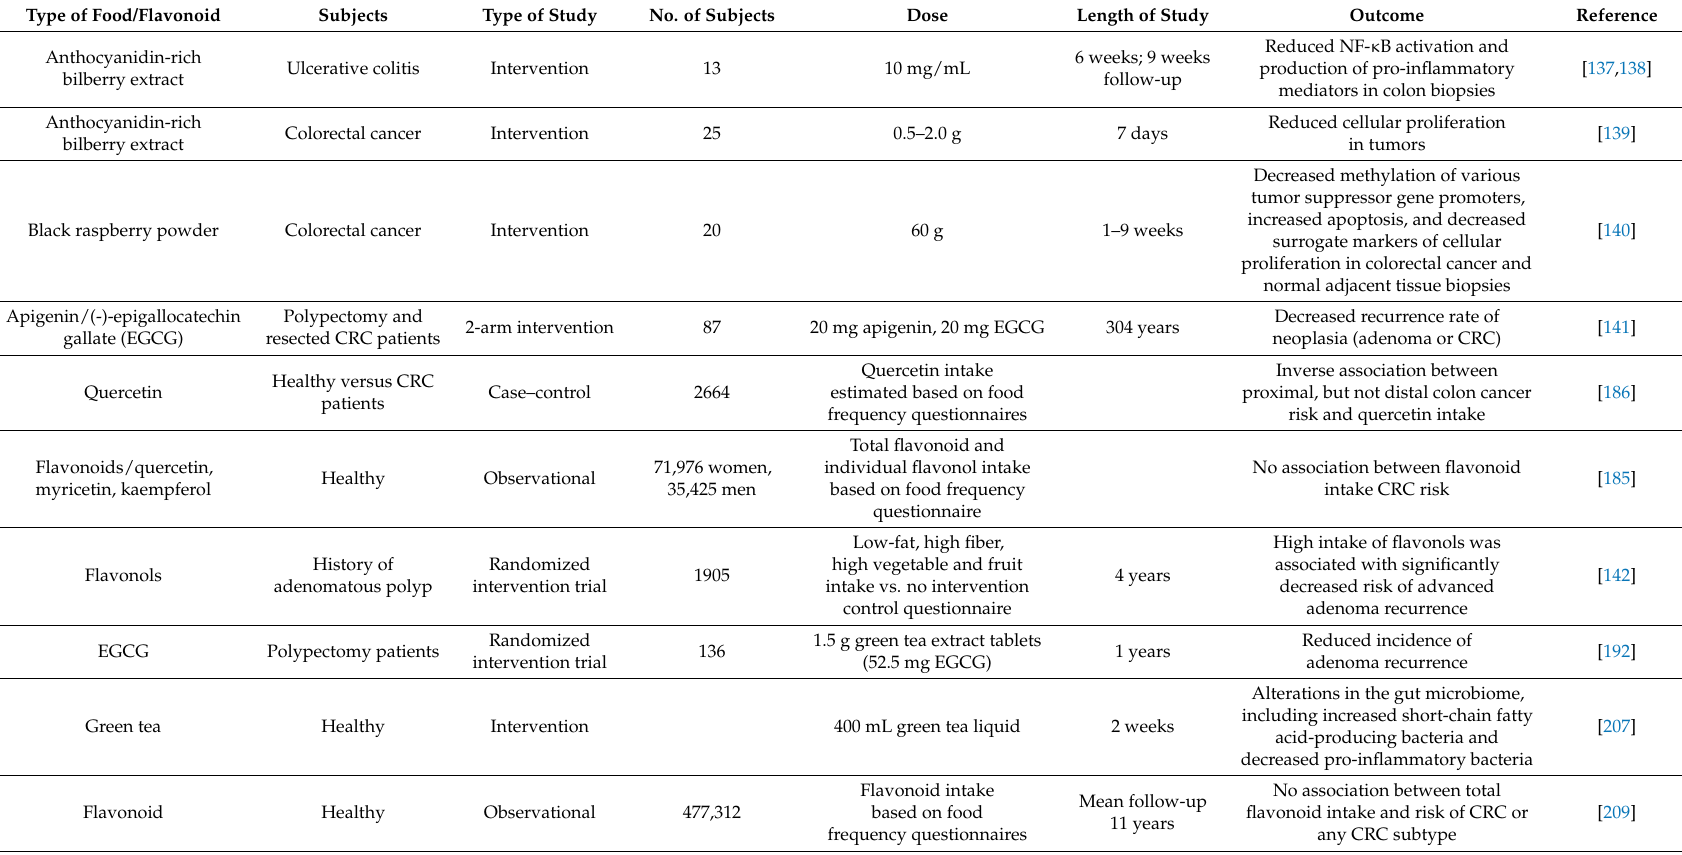
Table 1. Select human studies of flavonoids and colorectal